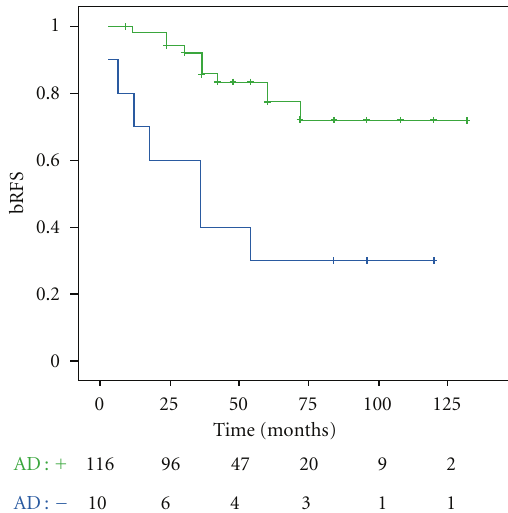
Figure 2: Biochemical relapse-free survival for patients treated with high-dose IMRT with or without androgen deprivation.